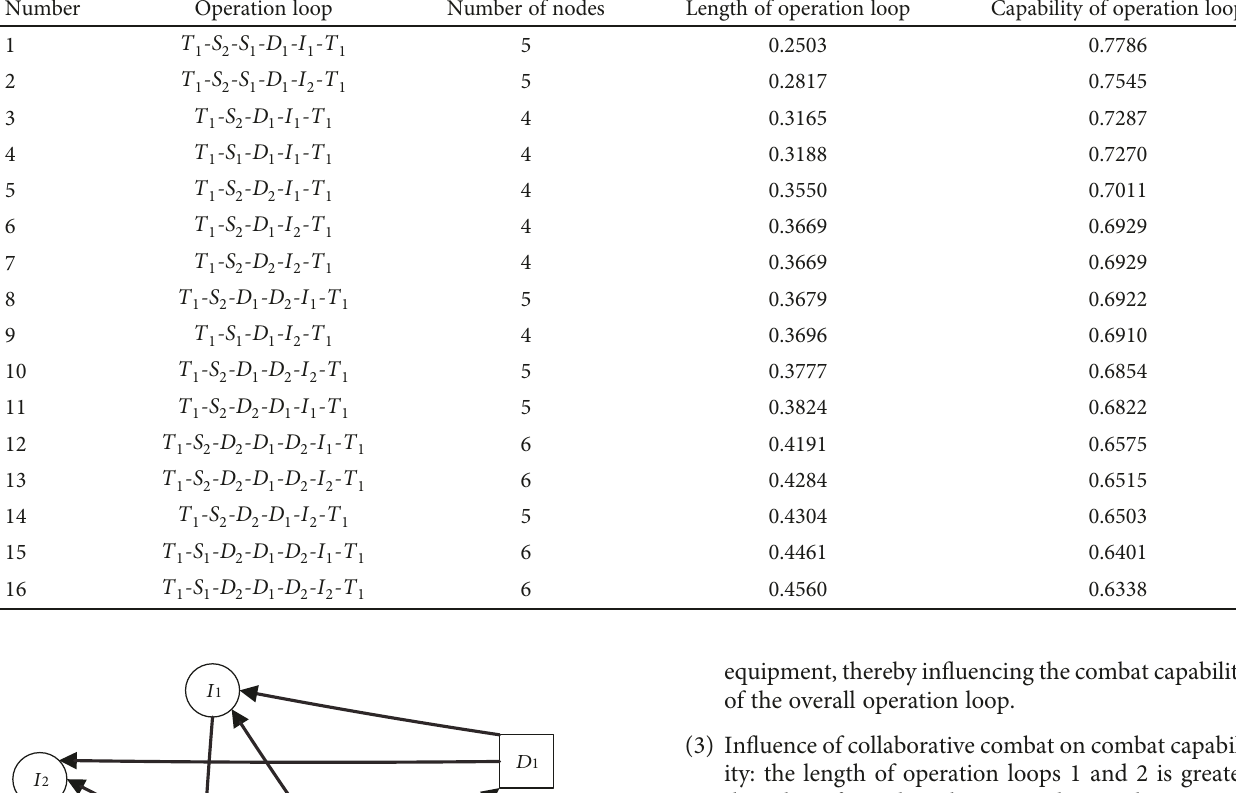
Table 6: Capability and length of operation loops aimed at target T